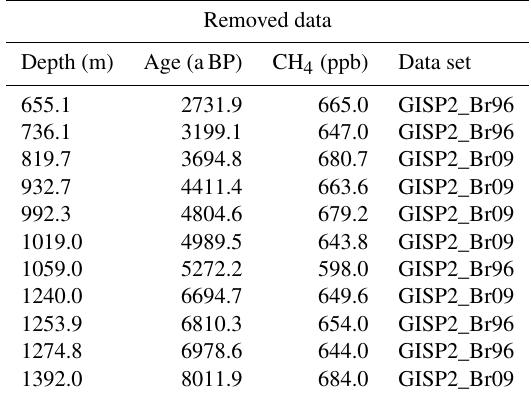
Table 4. GISP2 outliers. Data points that were removed from the two GISP2 data sets by Brook et al. (2009) and Brook (1996) due to elevated CH 4 values probably due to contamination related to the ice sample quality in the brittle zone. Please note that the age and the concentration values are corrected for the age shift and the CH 4 correction,